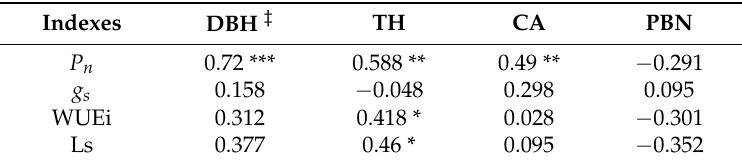
Table 2. Correlations between gas exchange parameters and growth indexes for S. matsudana saplings ( n = 27).